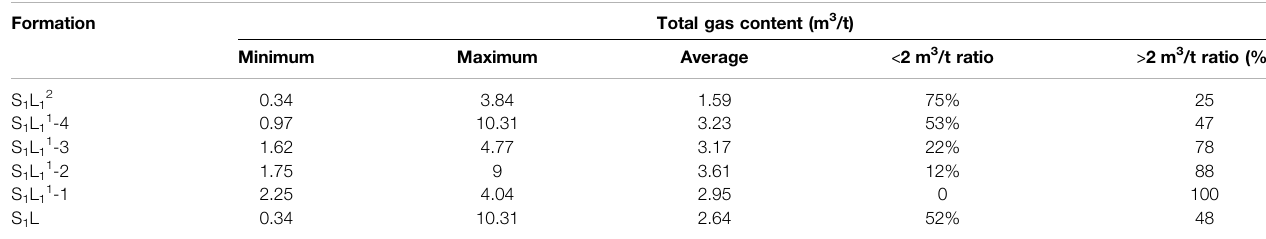
TABLE 3 | The total gas content of fi eld desorption in the Longmaxi Formation.